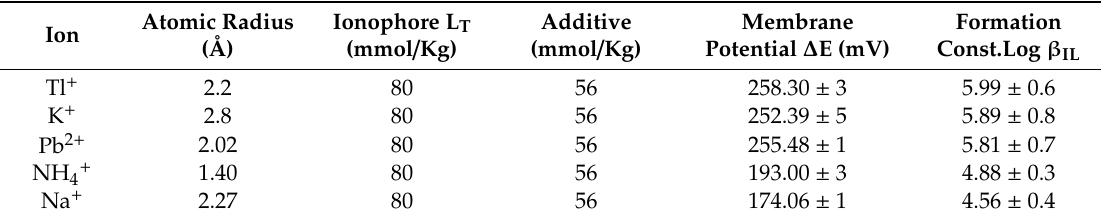
Table 2. Complex formation constants, Log β ML of dibenzo 18-crown-6 with various cations, measured in o -NPOE plasticized poly (vinyl chloride)